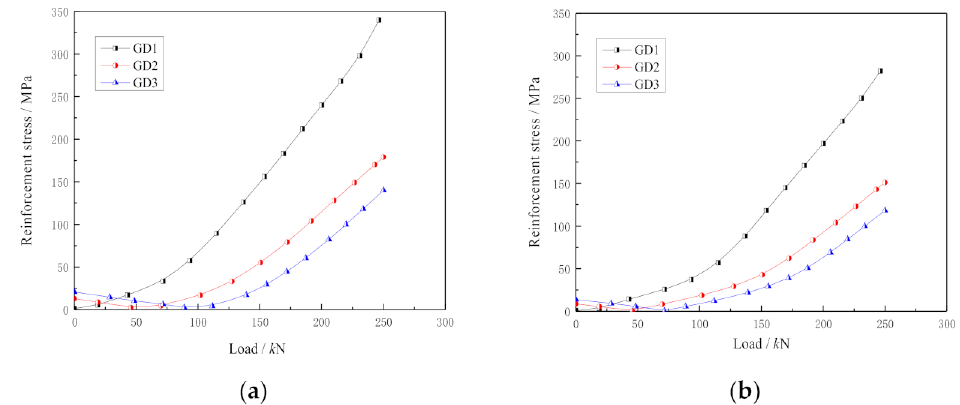
Figure 22. Stress-load curve of No. 2 steel bar: ( a ) B measuring point and ( b ) C measuring point.